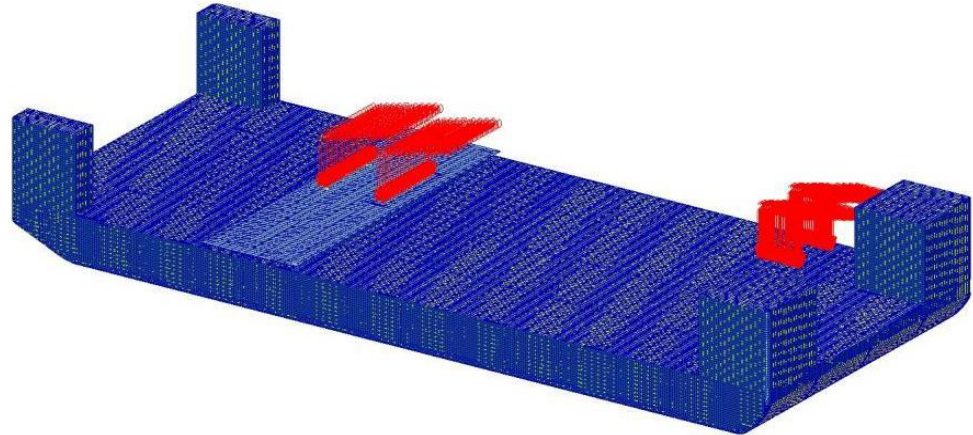
Figure 9. Load loading diagram.